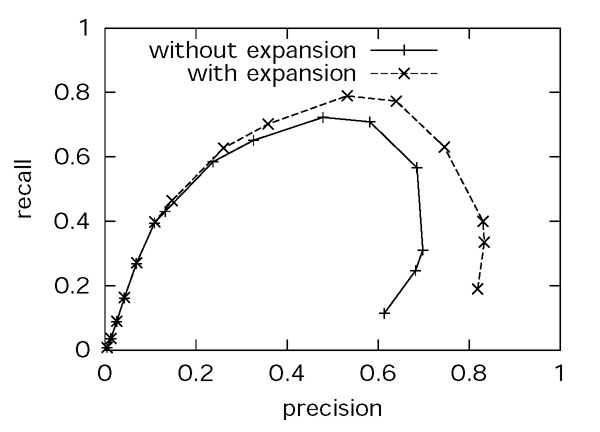
Recall/precision with and without post-expansion. Comparison of recall and precision before and after the post-expansion step. We use the full feature set (marked "100%" in Figure 2) for this evaluation. We obtain the different spots by parallelly shifting the hyperplane.